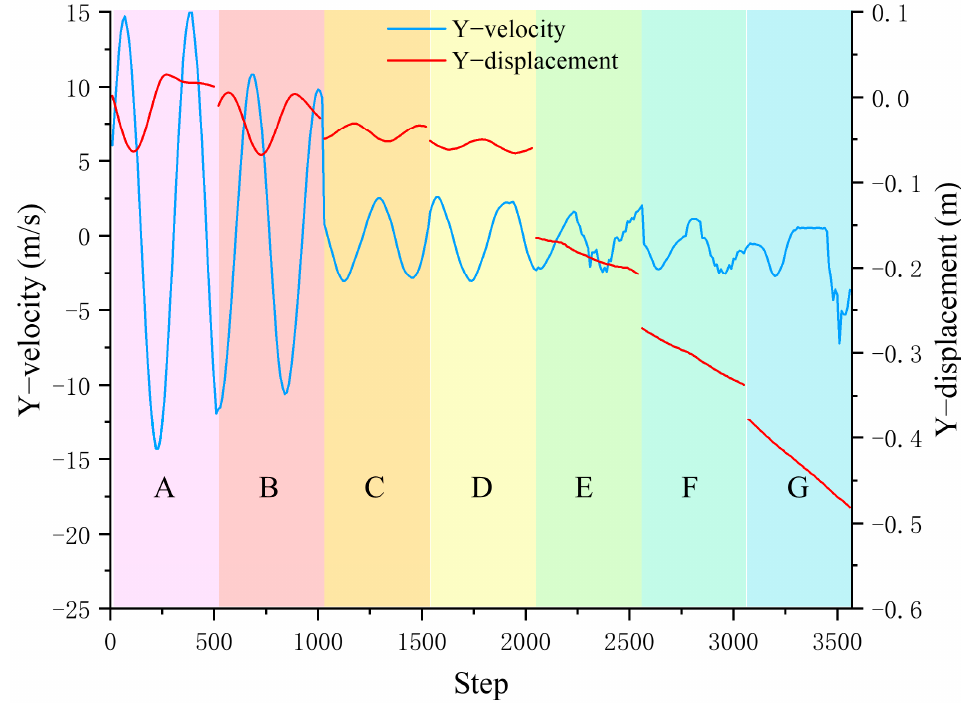
Figure 8. Y − velocity and Y − displacement curve of monitoring point.